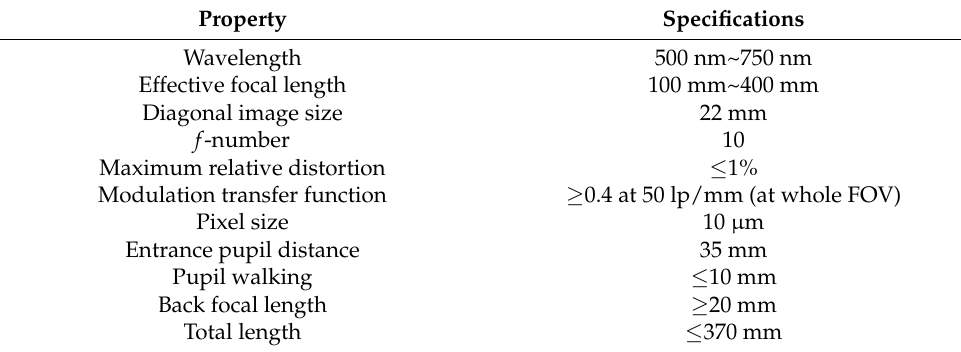
Table 1. Specifications for the 4 × zoom